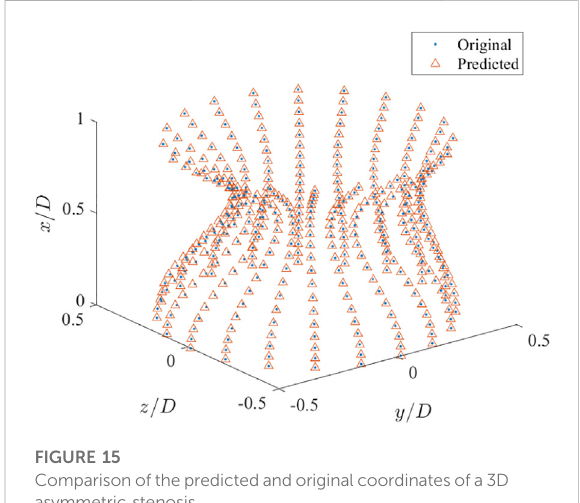
FIGURE 15 Comparison ofthepredictedandoriginalcoordinatesofa3D asymmetric stenosis.